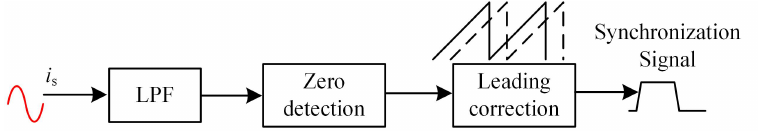
Figure 7. Synchronization circuit for semi-bridgeless active rectifier